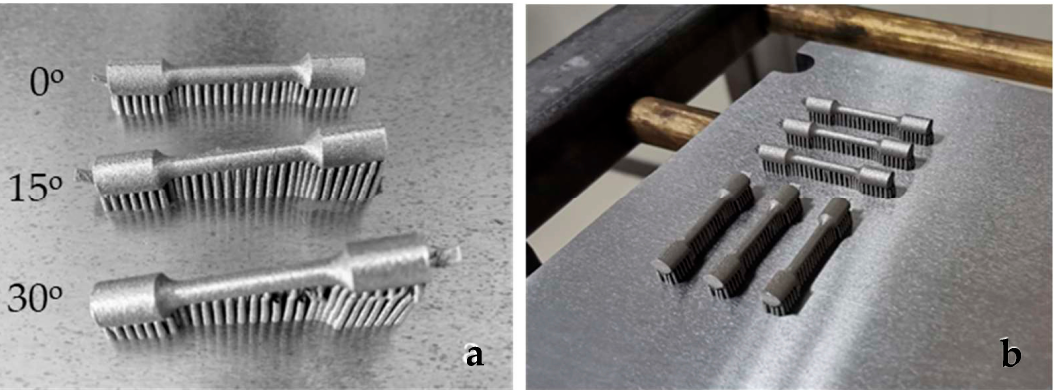
Figure 2. ( a ) S1 group specimens on the CNC machine platform immediately after sintering and before cutting the supports; ( b ) S2 group specimens on the CNC machine platform immediately after sintering and before cutting the supports.